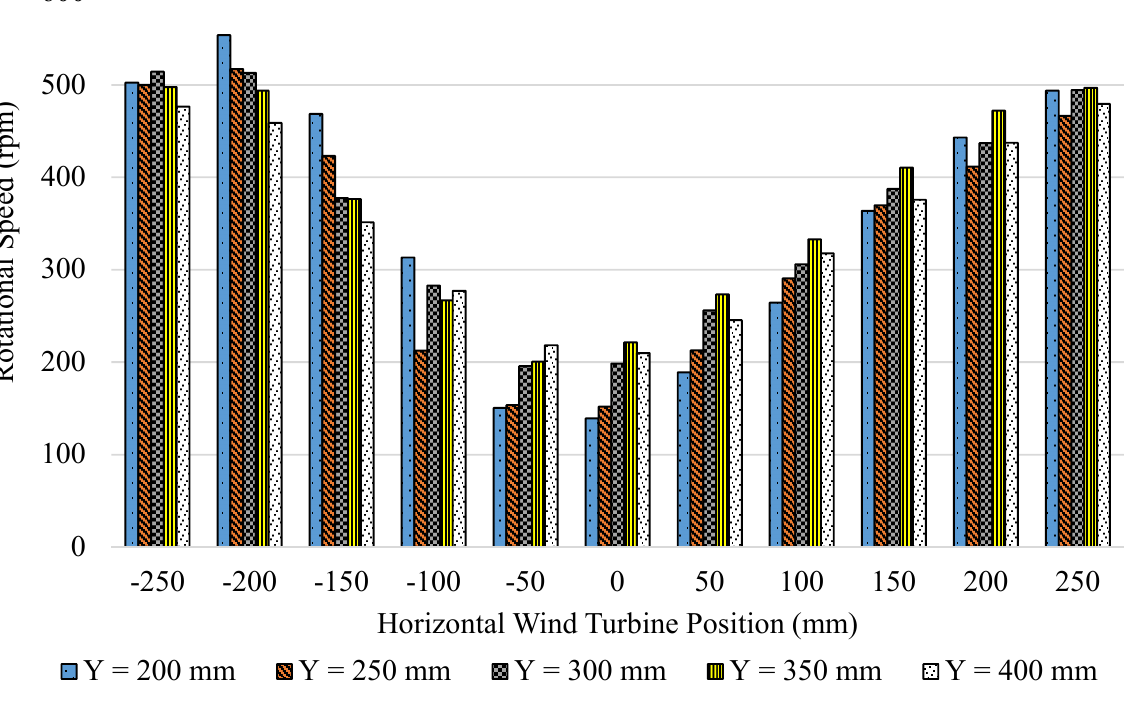
Figure 9. Rotational speed of wind turbine at various